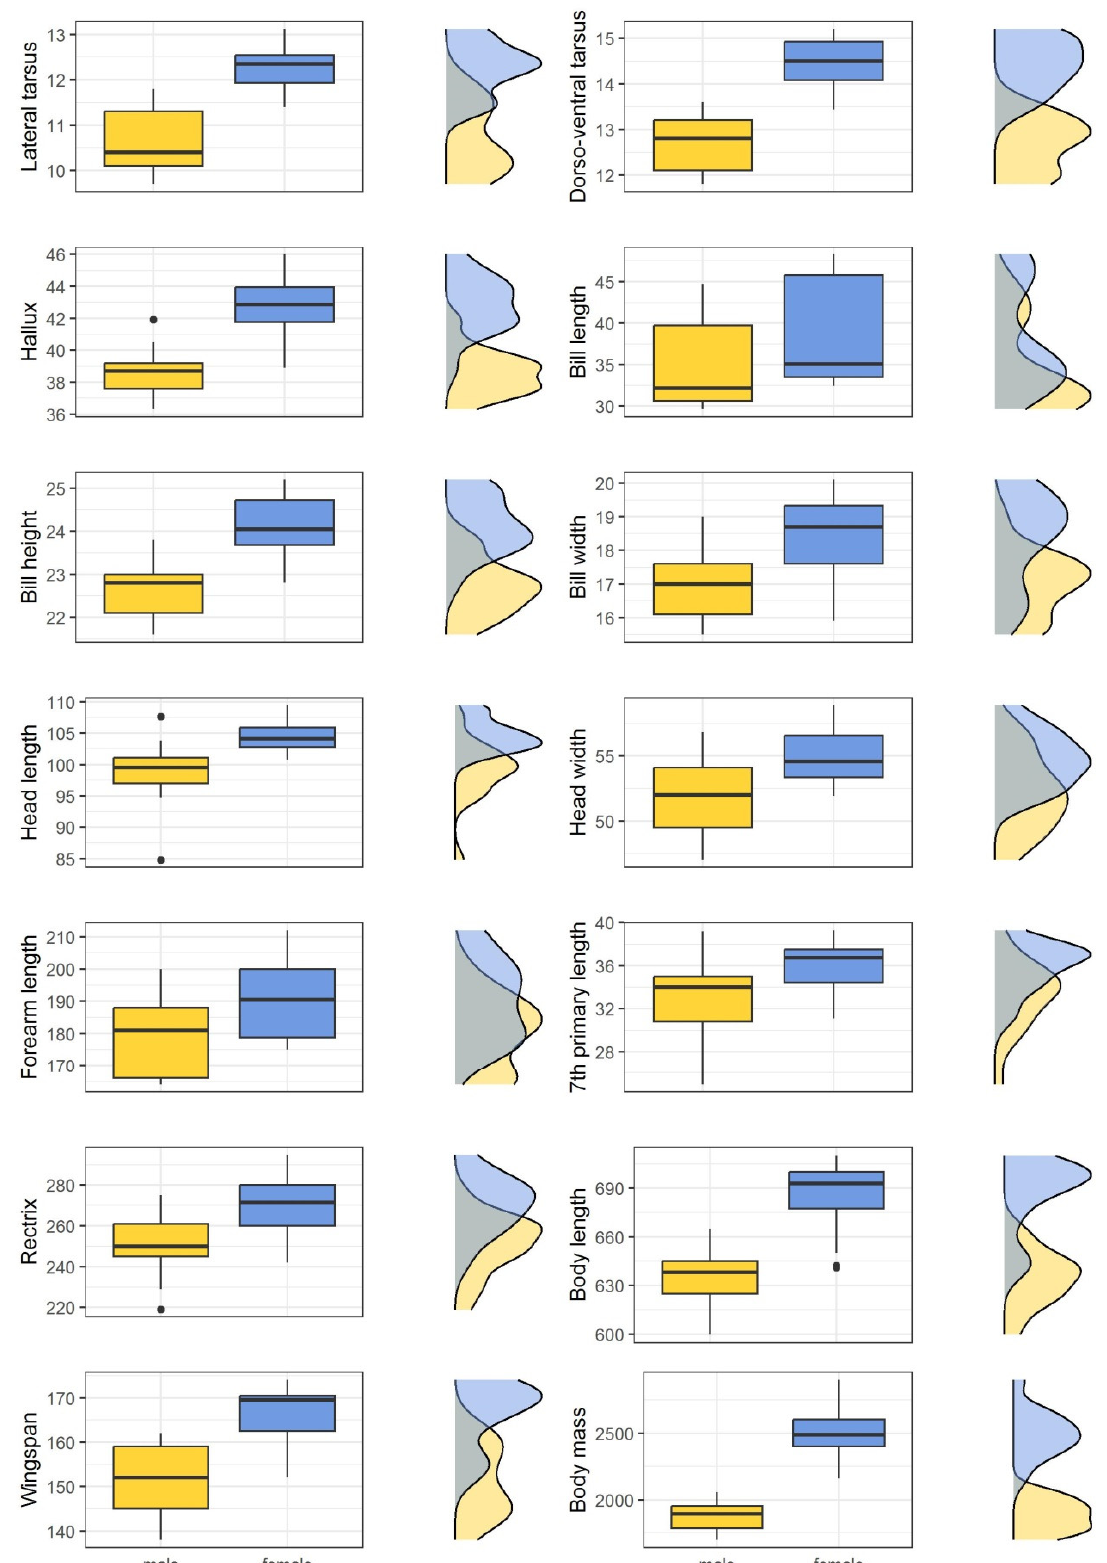
Figure 2. Morphometrics of adult male ( n = 17) and female ( n = 16) Bonelli’s eagles from eastern Spain sexed by molecular techniques. Measurements are given in mm. Density plots are shown to the right of each fi gure.